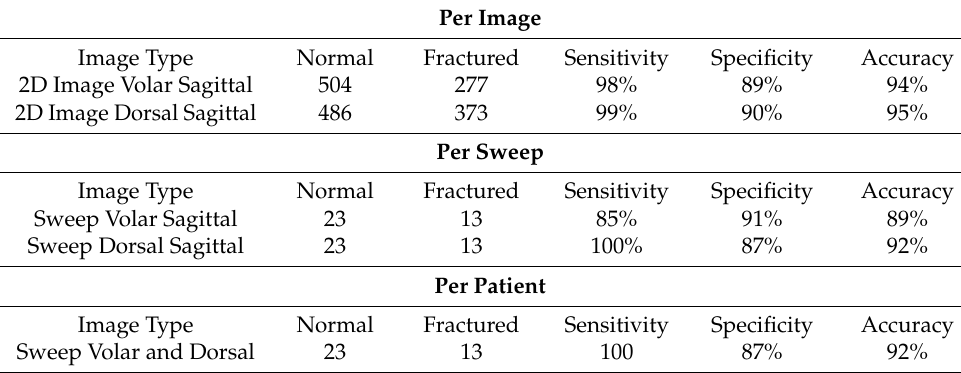
Table 3. Diagnostic accuracy of AI evaluation on individual image slices (per slice), 3DUS sweeps (per sweep), and at the patient level (per patient) in test data not used for AI network